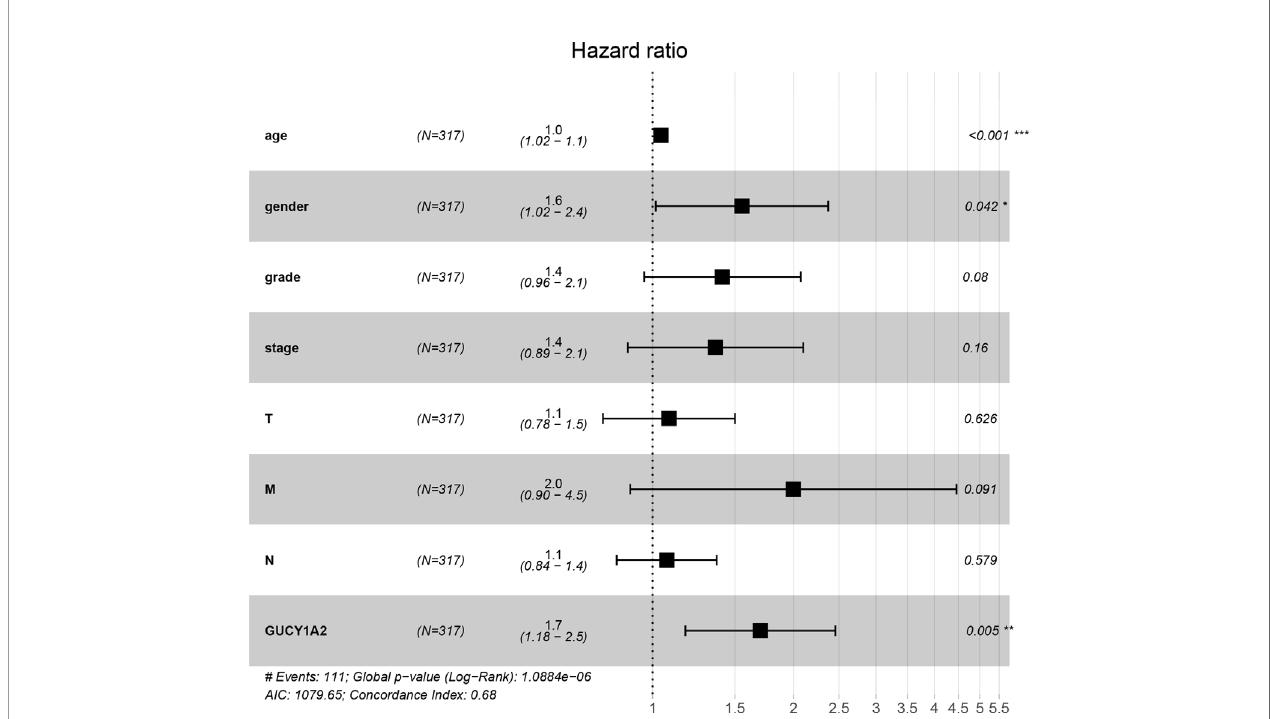
FIGURE 5 | Forest plot of the multivariate Cox regression model. GUCY1A2 was an independent predictor of poor survival rate (HR = 1.699; 95%CI, 1.175-2.456; P = 0.005). HR, hazard ratio; CI, con fi dence interval. * P < 0.05, ** P < 0.01, *** P < 0.001.